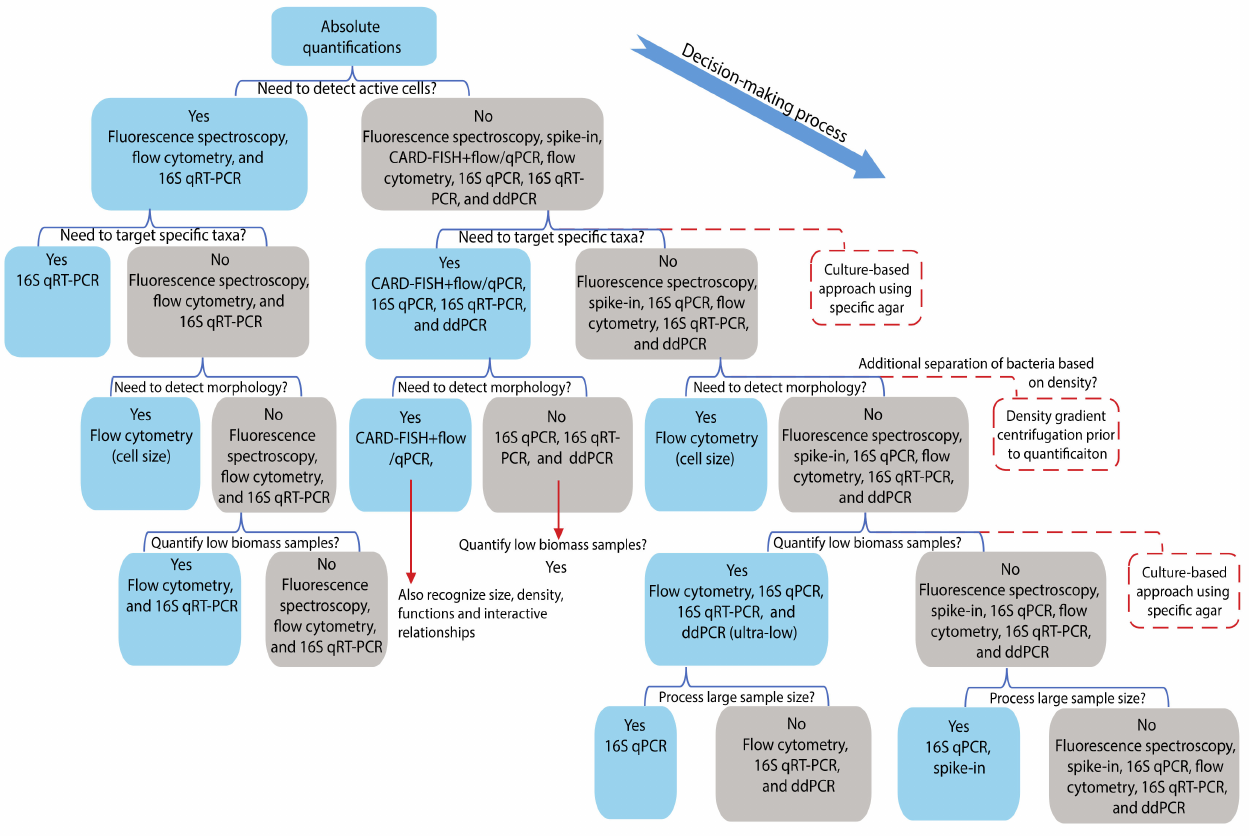
Figure 4. Decision-making process of absolute quantification